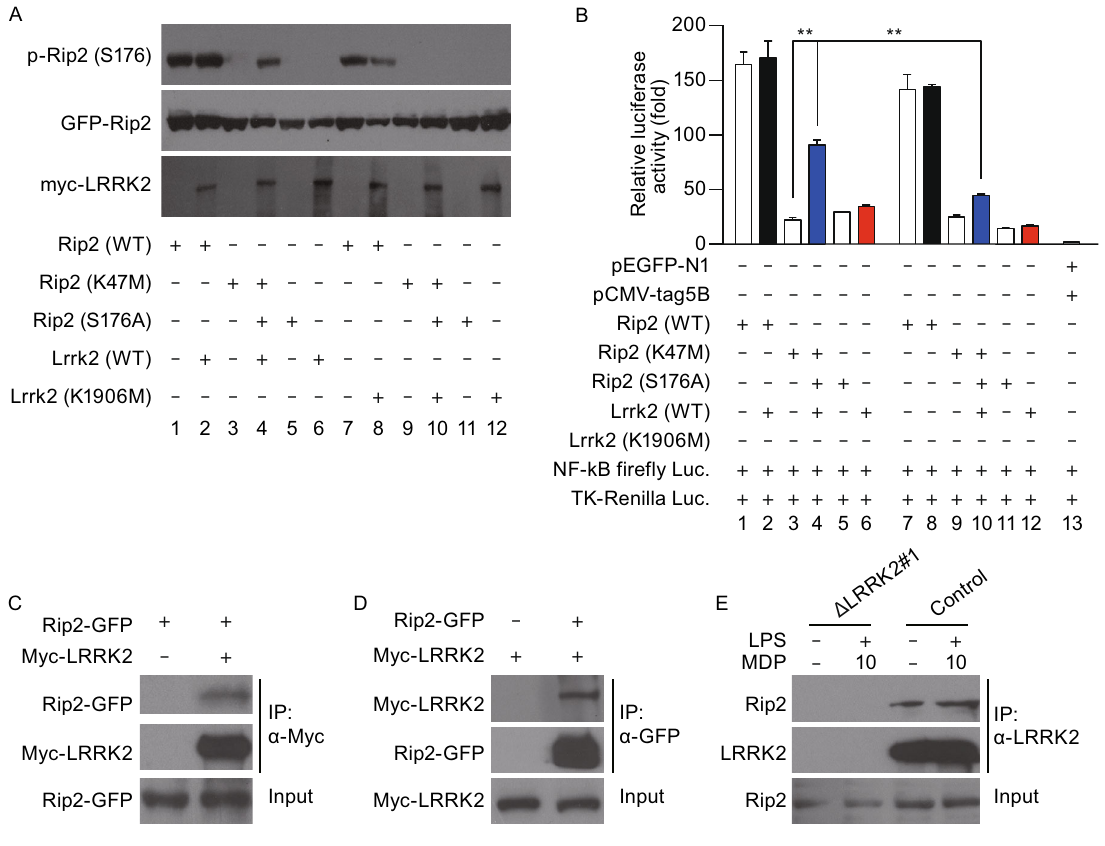
Figure 6. LRRK2 enhances the phosphorylation of Rip2 at Ser176. (A) The level of phosphorylated-Ser176 Rip2 was determined by immunoblotting of lysates from HEK293T cells transfected with WT LRRK2 or kinase-dead LRRK2 (K1906M) together with the Rip2 variants WT, K47M or S176A, or empty vectors. The levels of total Rip2 and LRRK2 were analyzed at the same time. (B) Relative NF- κ B activity was analyzed using a dual luciferase assay in HEK293Tcells transfected with WT LRRK2 or the kinase- dead LRRK2 mutant (K1906M) together with the Rip2 variants WT, K47M or S176A, or empty vectors. Data are expressed as mean ± s.e.m. * P < 0.05, ** P < 0.01, *** P < 0.001, NS denotes not signi fi cant, by Student ’ s t -test. (C – E) Co-immunoprecipitation analysis of the interaction between overexpressed LRRK2 and Rip2. Tagged LRRK2 and Rip2 were overexpressed in HEK293T cells, immunoprecipitated (IP) with anti-Myc (C) or anti-GFP (D) beads and immunoblotted with designated antibodies. (E) Co- immunoprecipitation analysis of the interaction between endogenously expressed LRRK2 and Rip2. Control THP-1 cells and THP-1 cells with LRRK2 knockout ( Δ LRRK2 #1) were treated with 5 ng/mL LPS and 10 μ g/mL MDP for 4 h, or mock-treated, immunoprecipitated with anti-LRRK2 antibody. Rip2 was immunoblotted in input fraction and immunoprecipitated fraction. Data are representative of three independent experiments (A –